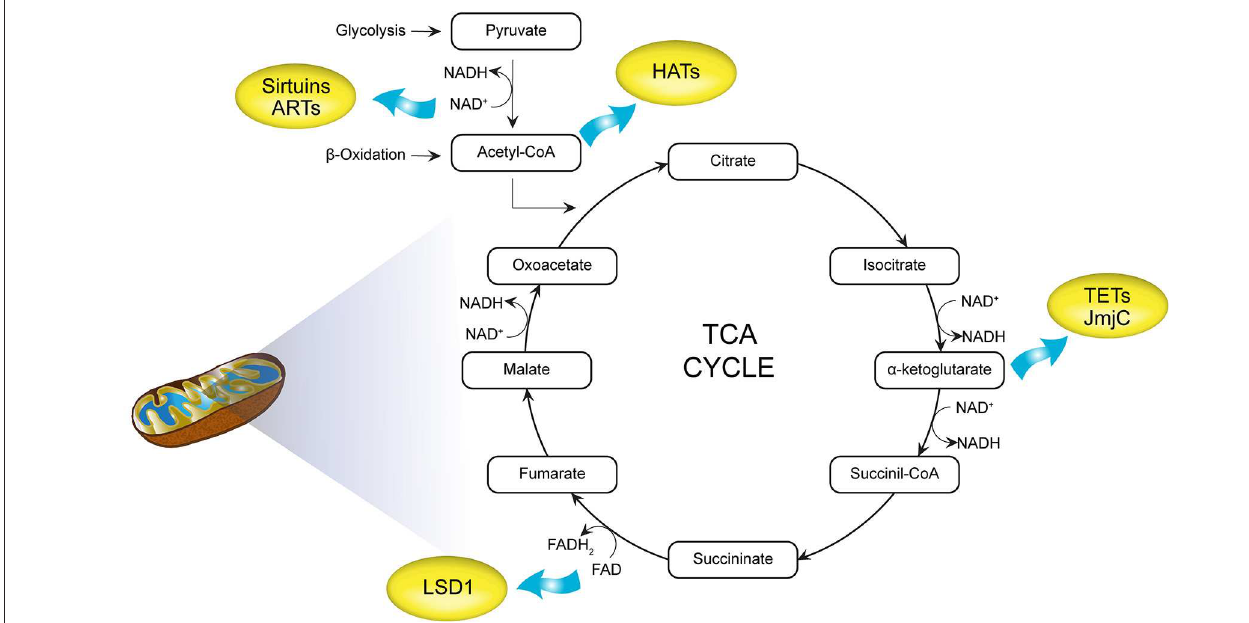
FIGURE 4 | Intermediate mitochondrial metabolites as cofactors for chromatin modifications. acetyl-CoA generated by glycolysis and β -oxidation acts as a substrate for histone acetyltransferases (HATs). Nicotinamide adenine dinucleotide (NAD + ) is required for histone deacetylases (HDACs; histone deacetylation) as well as ADP-ribosyltransferases (ARTs). α -Ketoglutarate and flavin adenine dinucleotide (FAD + ) are cofactors for DNA (ten-eleven translocations, TETs) and histone demethylases [Jumonji C domain containing (JmjC), LSD1]. TCA, tricarboxylic acid cycle; HATs, histone acetyltransferases; NAD + , nicotinamide adenine dinucleotide; HDACs, histone deacetylases; ARTs, ADP-ribosyltransferases; FAD, flavin adenine dinucleotide; TETs, ten-eleven